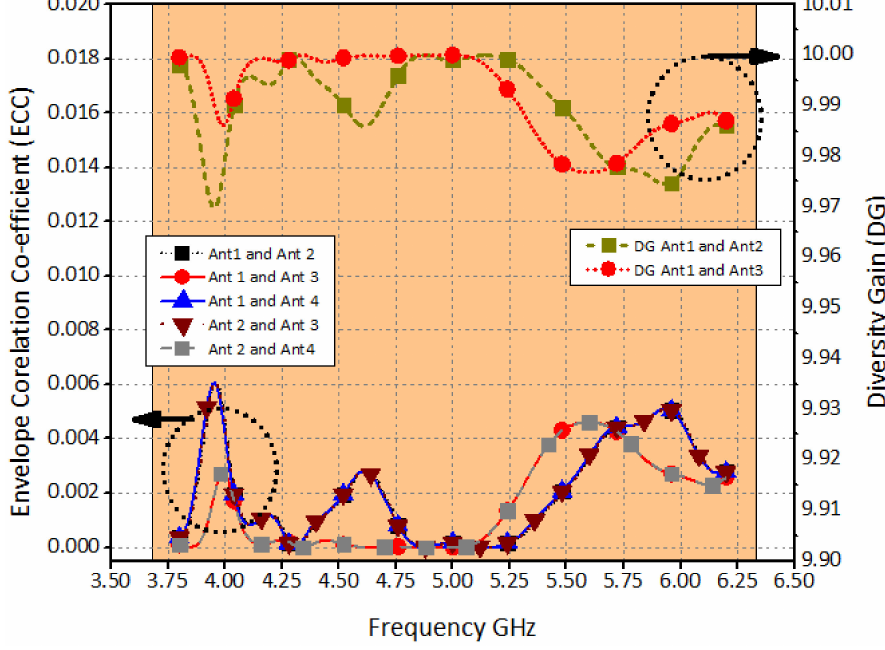
Figure 9. MIMO performance